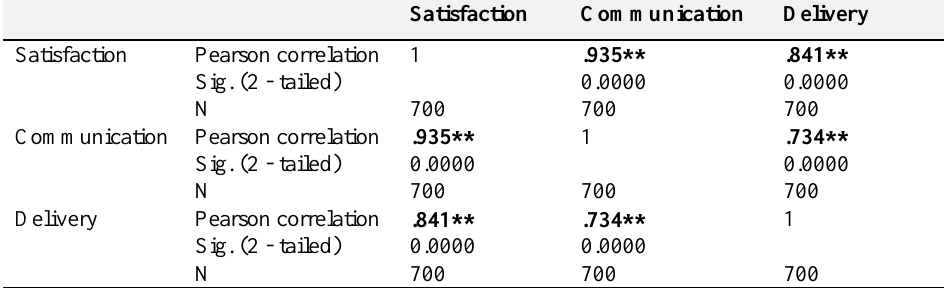
Table 7 – Pearson’s correlation E-shops in SK